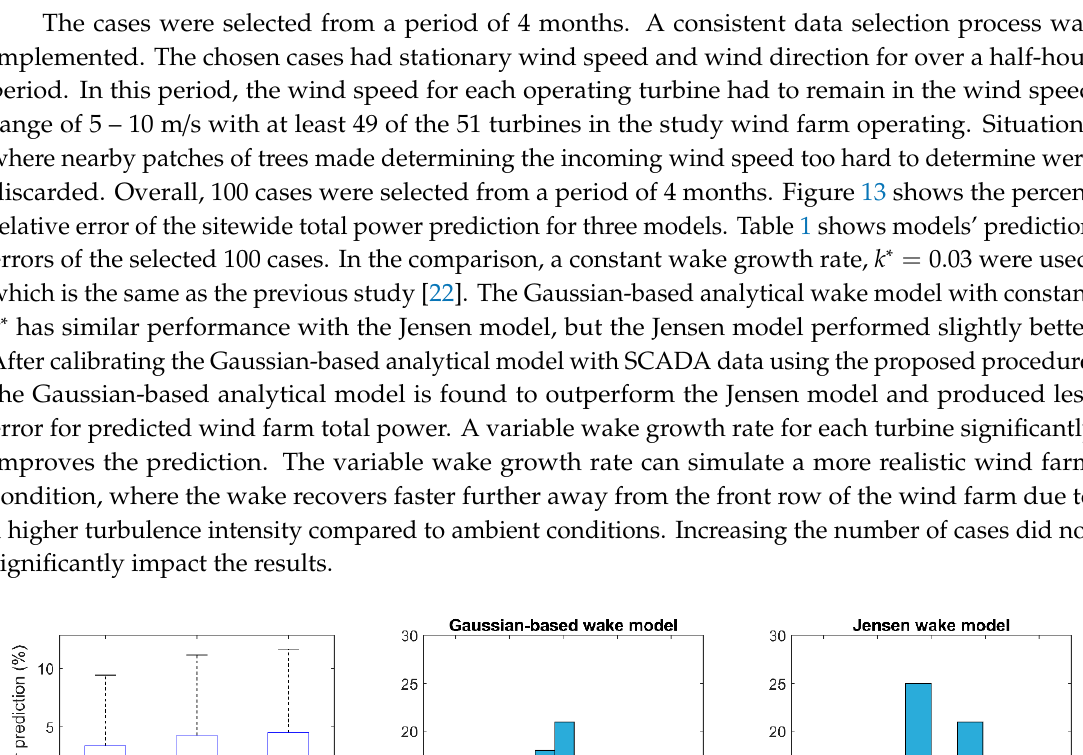
Figure 12. Streamwise wake of the three turbine array under the partial wake condition: ( a ) Gaussian-based analytical wake model and ( b ) Jensen model.